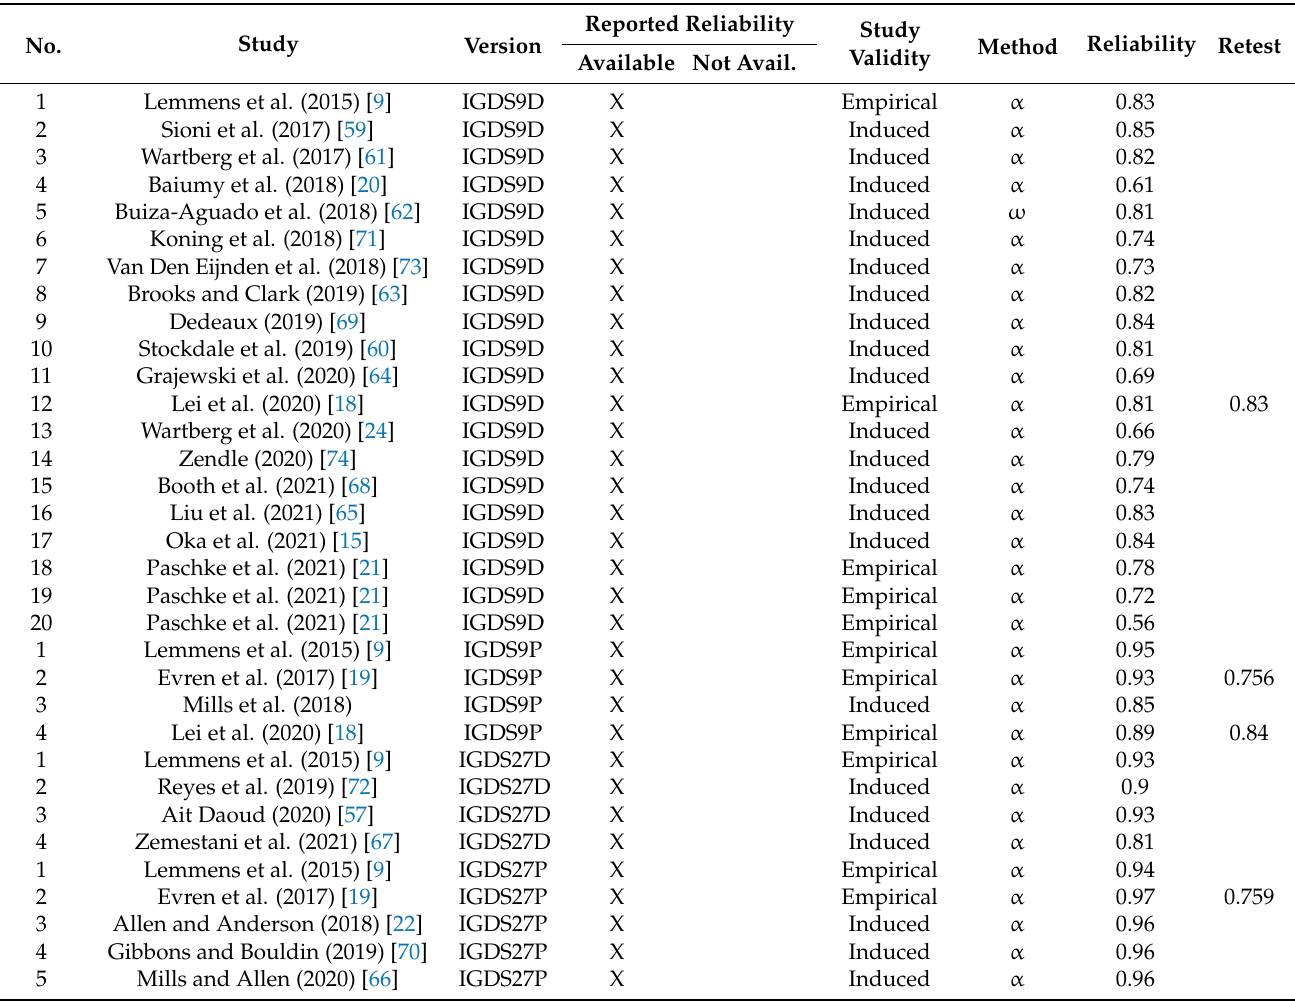
Table A2. Characteristics of the selected